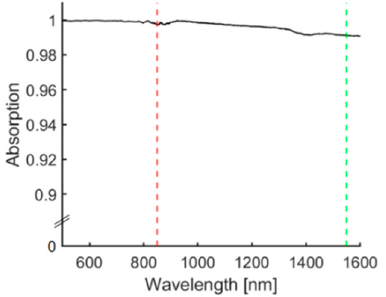
Figure 3. Absorption spectrum of CSNP-PDMS nanocomposite deposited onto the distal end of an optical fibre with absorption highlighted at 850 nm (dashed red line) used for PA generation of needle exterior and 1550 nm (dashed green line) used for optical ultrasound generation of the fibre